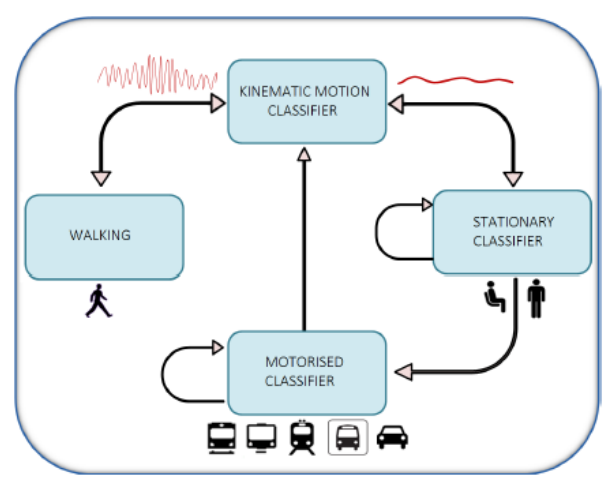
Figure 1 . Overview of the system architecture including three classifiers proposed by Hemminki et Al.